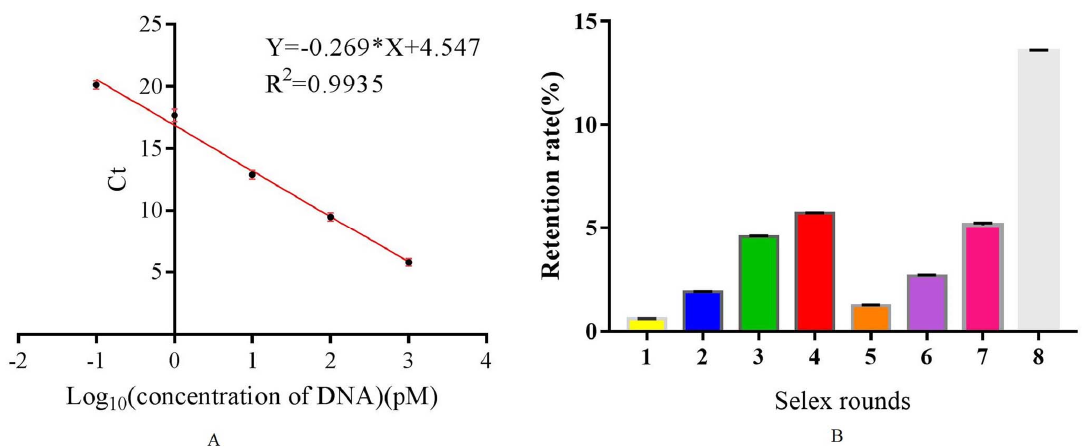
Figure 1. Q-PCR monitoring the process of selection. ( A ) The quantitative analytical curve of Q-PCR, ( B ) the retention rate for each round of selection.